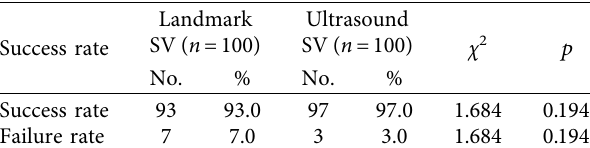
Table 8: Comparison between landmark and ultrasound in SV group (B) according to success